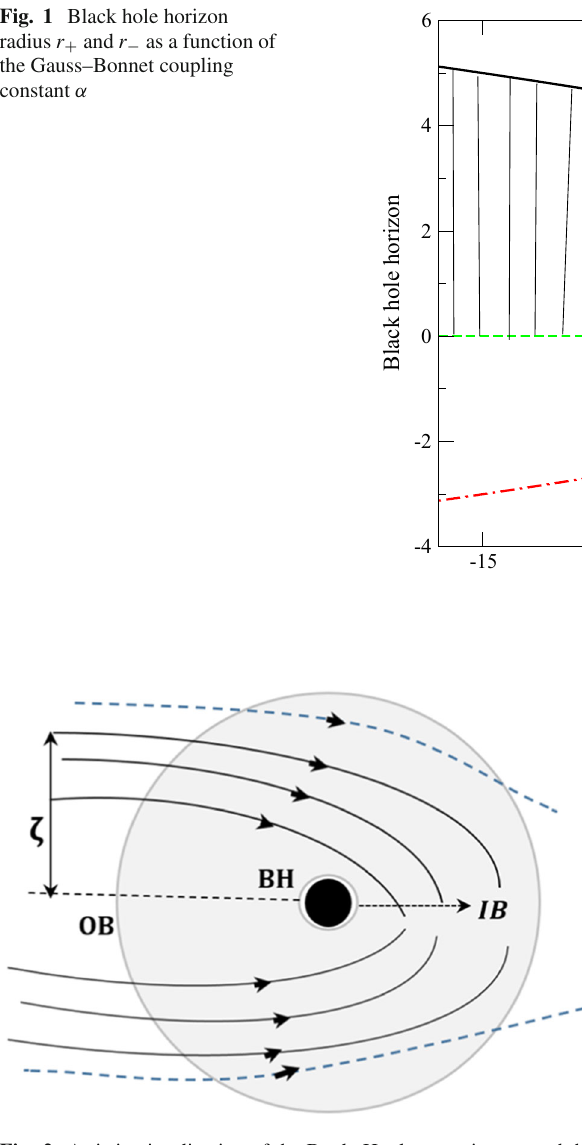
Fig. 2 Artistic visualization of the Boyle Hoyle accretion around the black hole. BH ≡ black hole, OB ≡ outer boundary, and IB ≡ inner